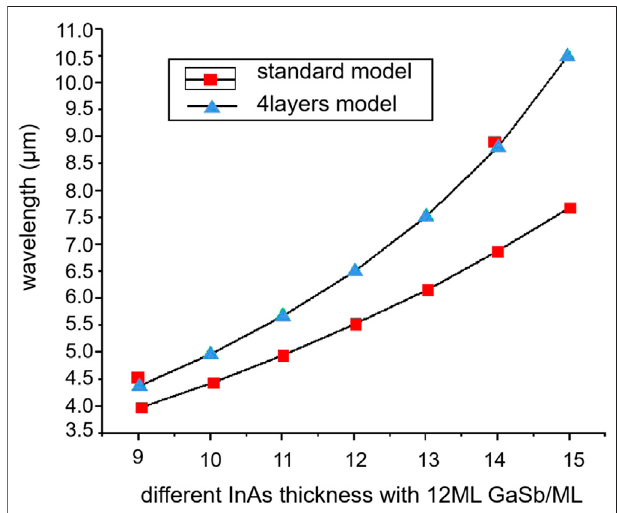
FIGURE 6 | Calculated band-structure of 13.5 ML/2 ML/8 ML InAs/ AlSb/GaSb T2SL showing dispersion of energy with respect to electron wave vectorinplane(k xy )andinthegrowthdirection(k z )forLWIRT2SL.Theinplane dispersion direction along [109] is shown on the left-hand, whereas the dispersion in the growth direction [001] is shown on the right hand. Conduction bands 1 and 2 zone edges at ( π /P) are presented as verticle dashed line (P is periodical